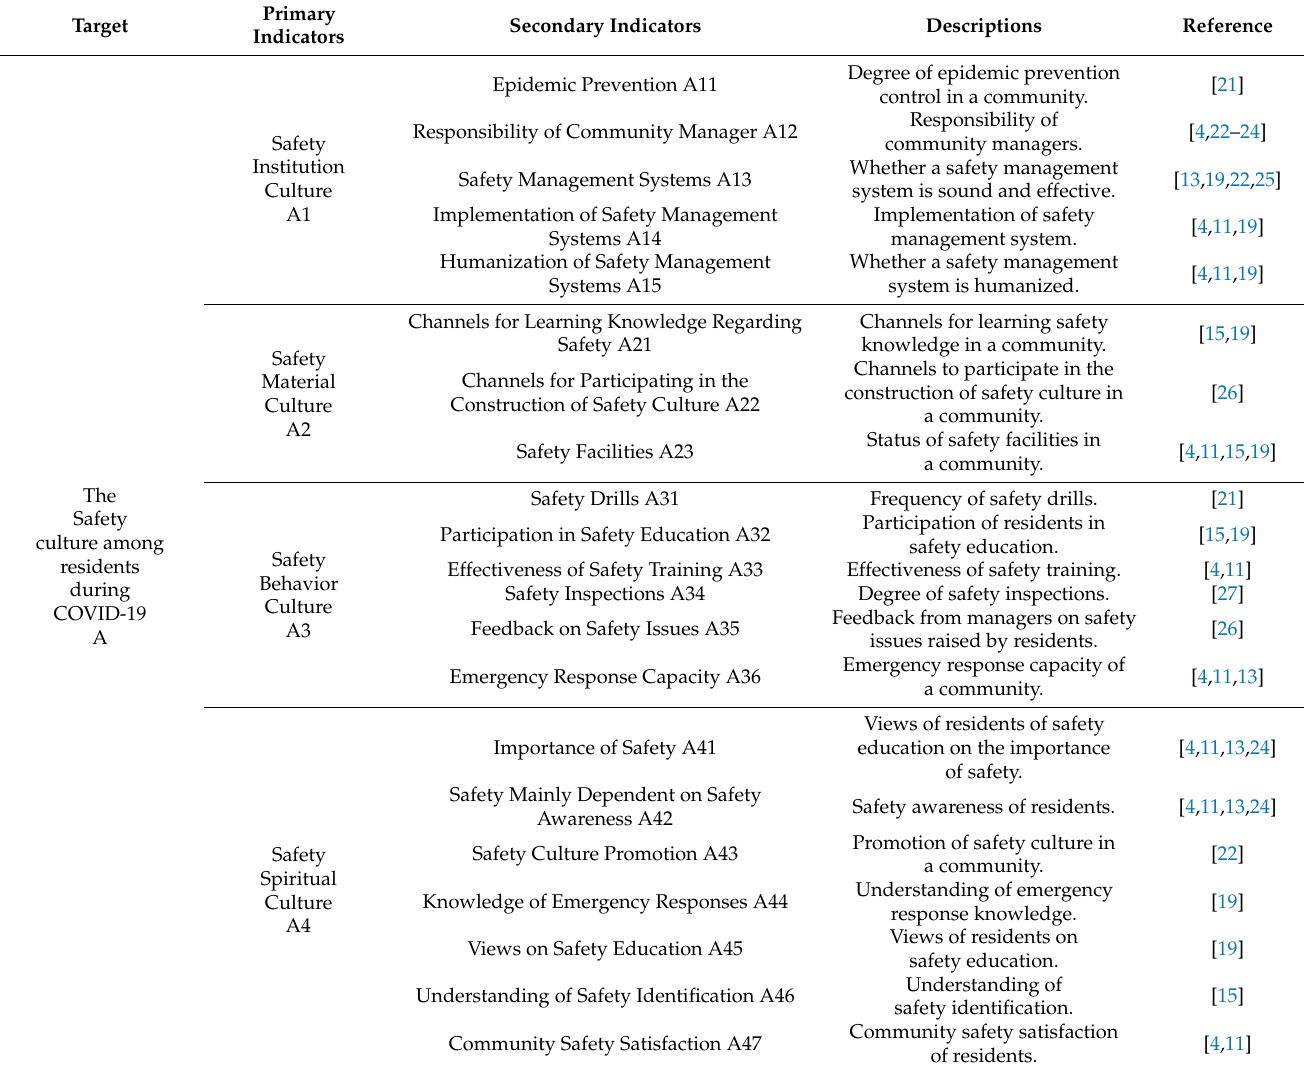
Table 1. Comprehensive evaluation indicator system of residents’ safety culture during